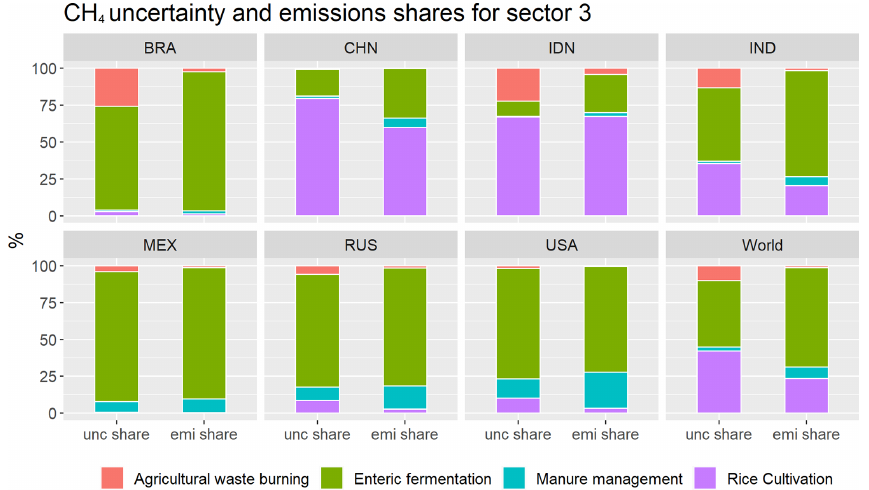
Figure 8. CH 4 uncertainty and emissions shares for EDGAR’s emission sectors under IPCC category 3 for Brazil, China, Indonesia, India, Mexico, Russia, the USA, and the